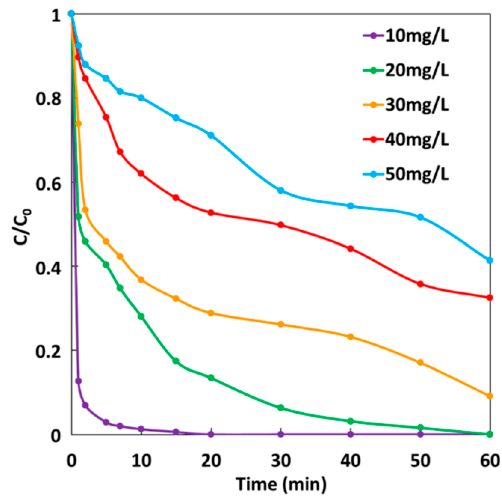
Figure 10. Effect of MG concentration on the degradation rate during the GF process.